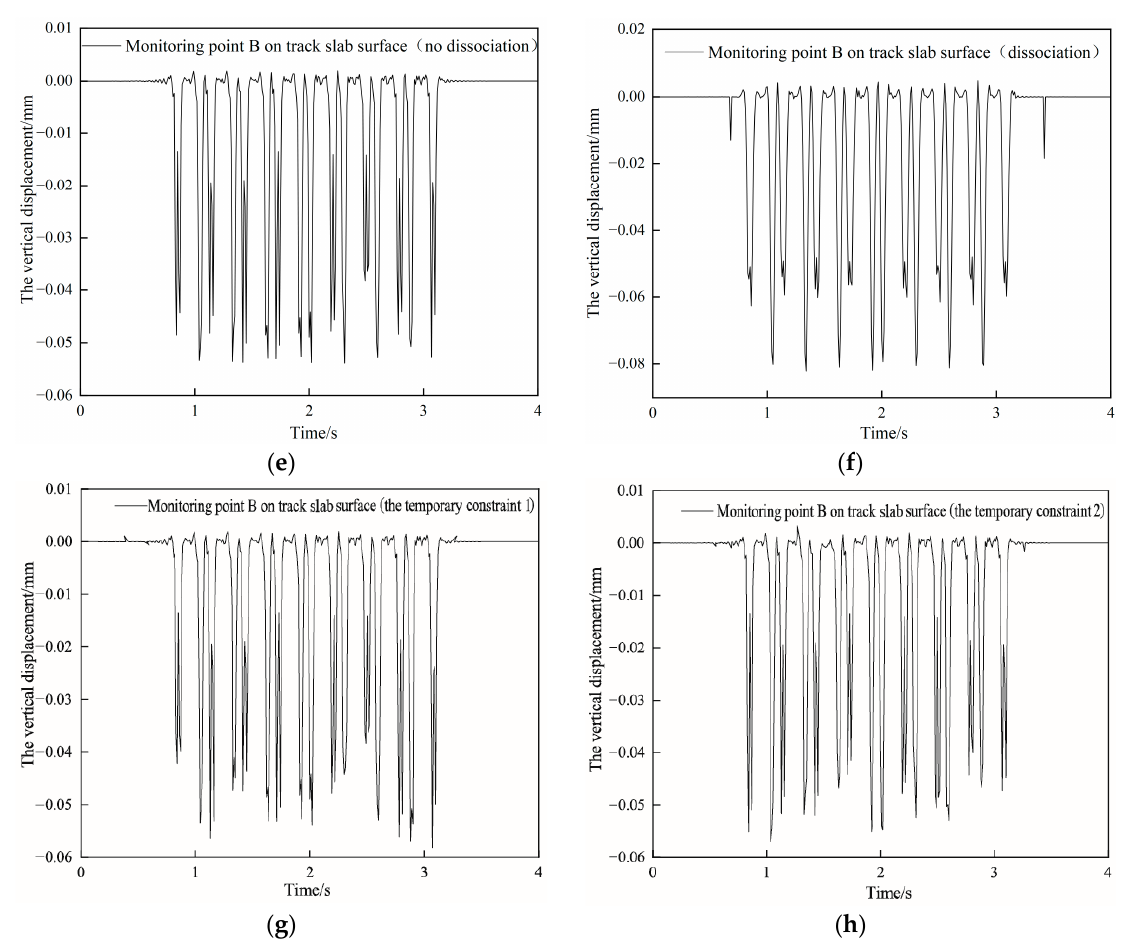
Figure 20. Acceleration time history curve of measuring point B under four different conditions: ( a ) no dissociation, ( b ) dissociation, ( c ) temporary restraint 1, ( d ) temporary restraint 2; Vertical displacement time history curve of measuring point B under four different conditions: ( e ) no dissociation, ( f ) dissociation, ( g ) temporary restraint 1, ( h ) temporary restraint 2.